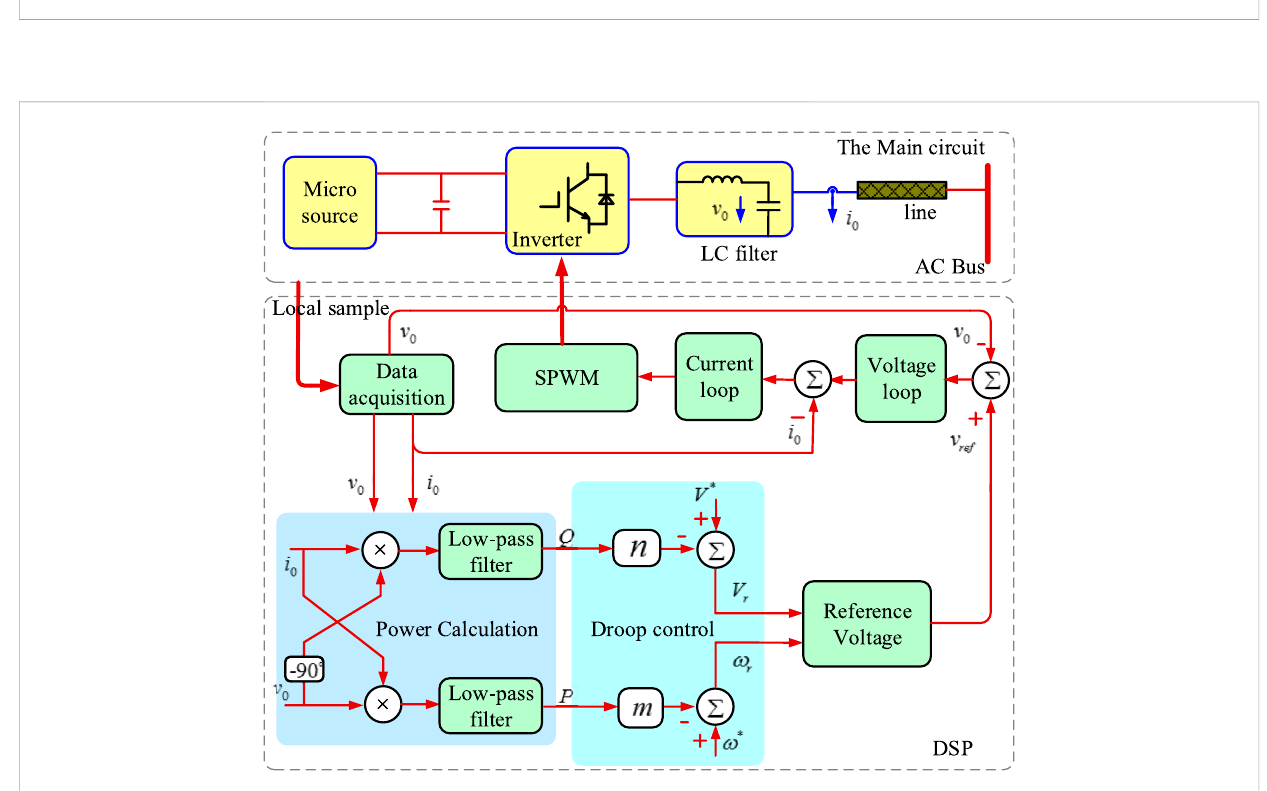
FIGURE 5 Overall control scheme for a single inverter with basic droop